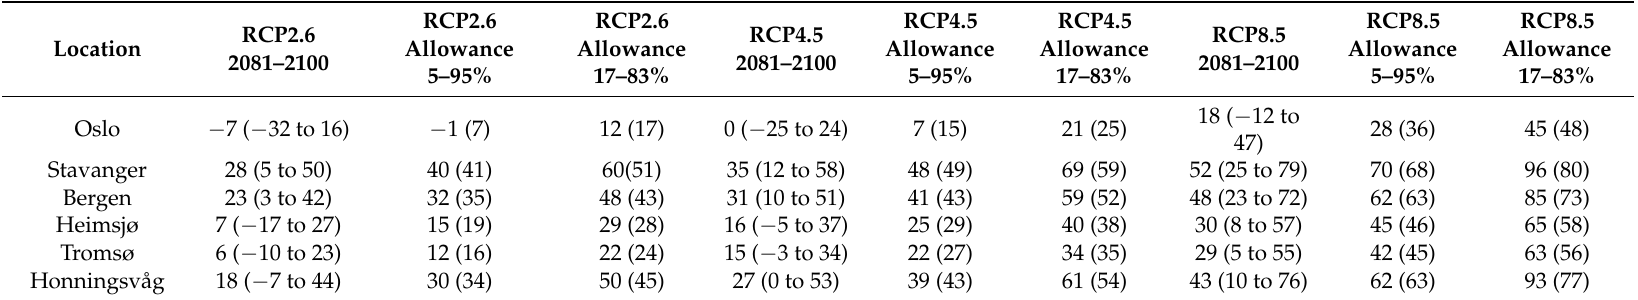
Table 3. Allowances (in cm) calculated for six key locations using the 20-year return heights and projected ensemble mean RSL change over the period 1986–2005 to 2081–2100 (the 5% to 95% ensemble spread is given in parentheses). Allowances are given for two different choices of the level of likelihood assigned to the ensemble spread. The parentheses next to the allowances give the value of the standard error above the ensemble mean projected RSL.